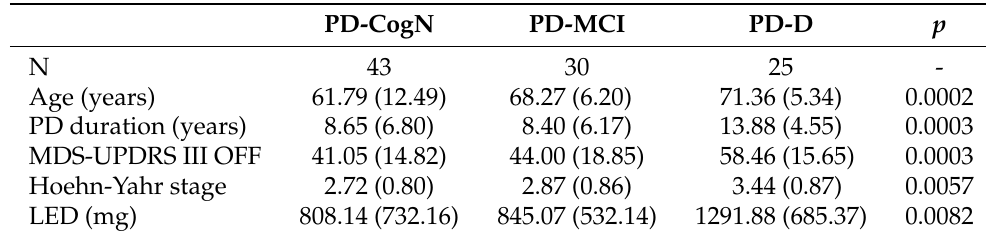
Figure 1. Flow chart of patients selection. Table 1. Clinical characteristics of PD-CogN, PD-MCI, and PD-D patients—mean (standard